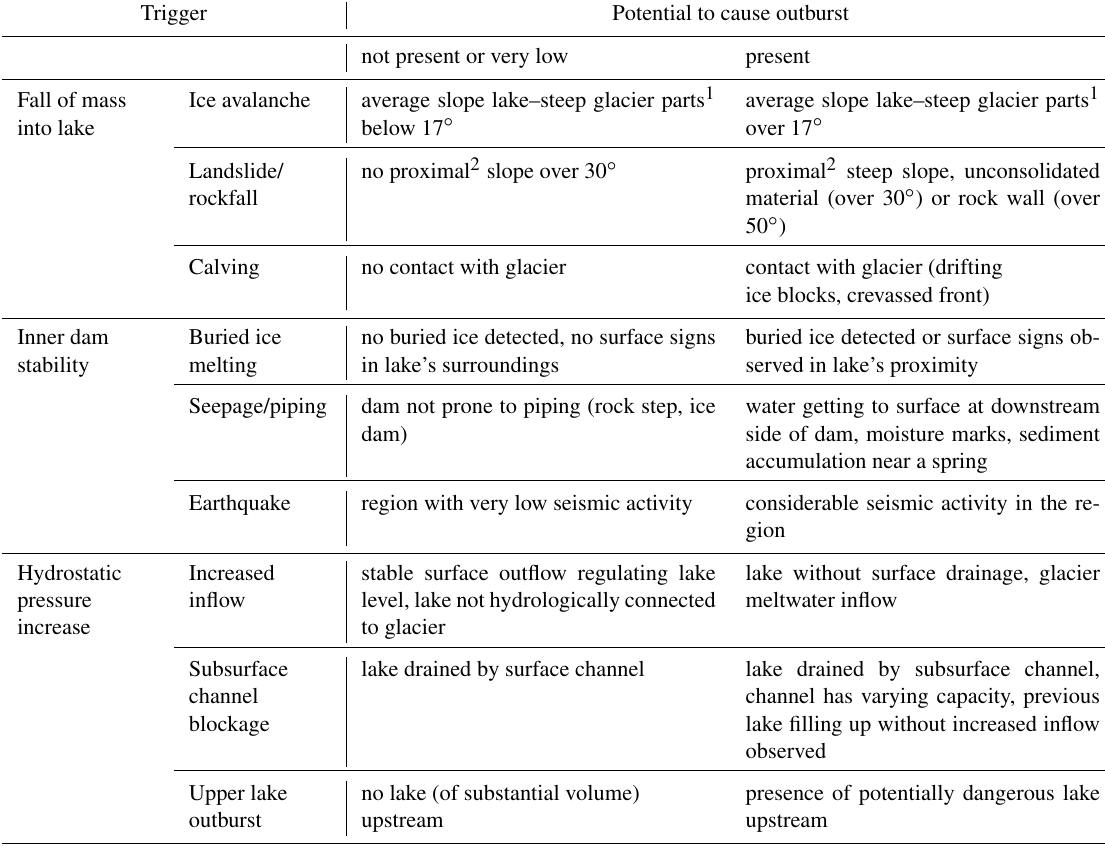
Table 4. Triggers with potential to cause lake outburst and their